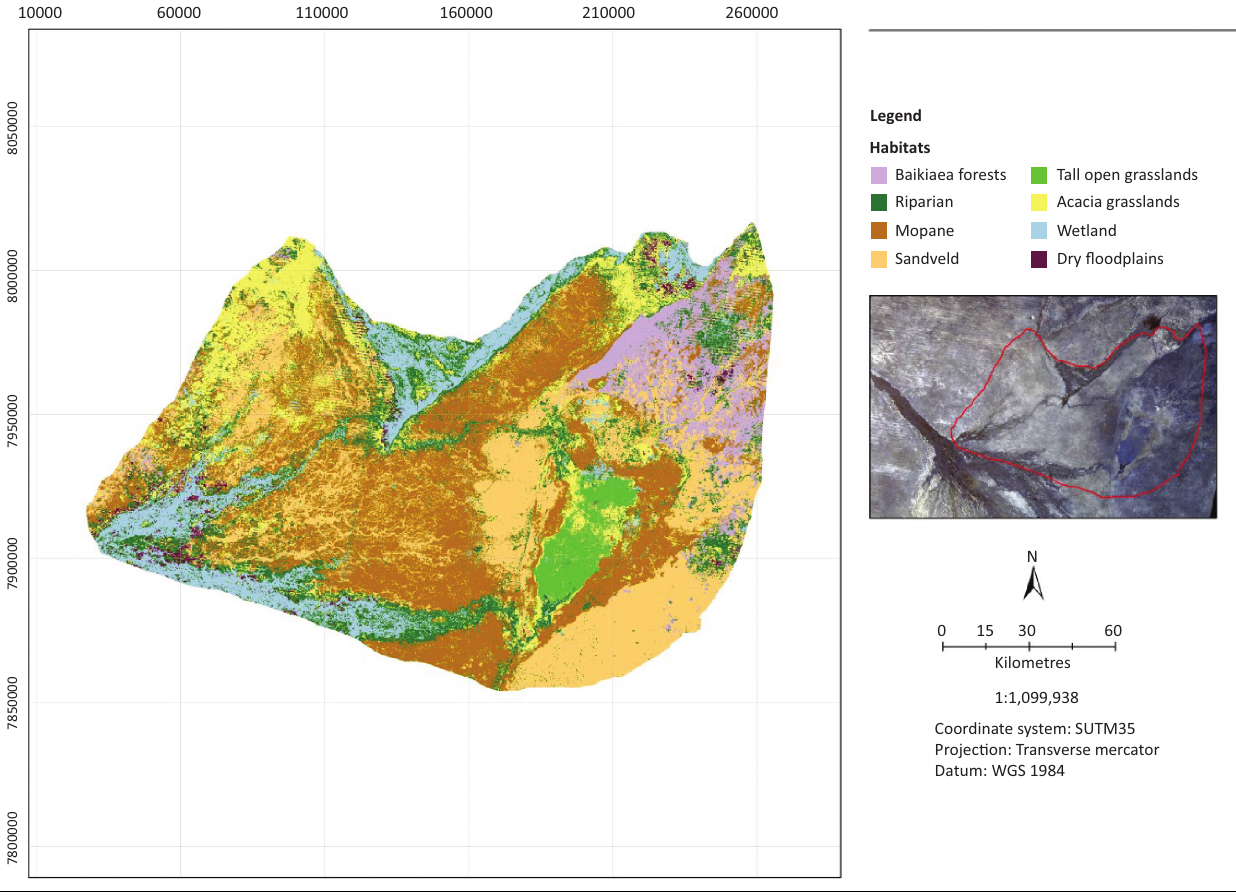
FIGURE 2: Map of Savuti-Mababe-Linyanti ecosystem Vegetation (northern